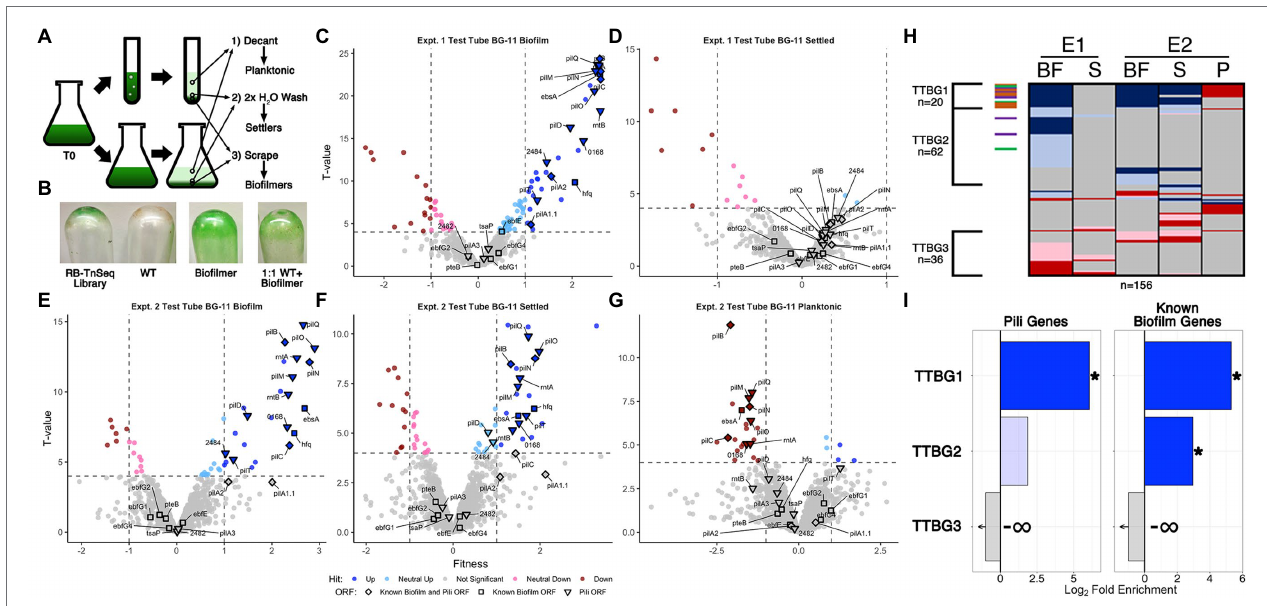
FIGURE 3 | RB-TnSeq analysis of biofilm forming cultures of the pooled TnSeq library. (A) Diagram of the RB-TnSeq library biofilm formation experiments and collection of samples. Triplicate samples were pooled prior to DNA extraction to ensure enough biomass and material for barcode sequencing. (B) Representative biofilms, or lack thereof, left attached to the glass after decanting and washing steps for the RB-TnSeq library, WT, a homogeneous biofilm formation strain, and a 1:1 mixture of WT and the biofilmation strain. Volcano plots of experiment 1 (E1) test tube (C) biofilm (BF) fractions and (D) settled fractions (S), and experiment 2 (E2) test tube fractions in BG-11 (E) biofilm, (F) settler, and (G) planktonic (P) fractions, presented as described for Figures 1B,C except that the x -axis is the fitness value and the y -axis is the T-value statistic. (H) Comparison of hit data for ORFs with significant fitness value changes, presented as described for Figure 1D , for all BG-11 test tube fractions. (I) Enrichment analyses for pili and known biofilm genes in the clusters of hits identified in (H) are presented as described for Figure 1E